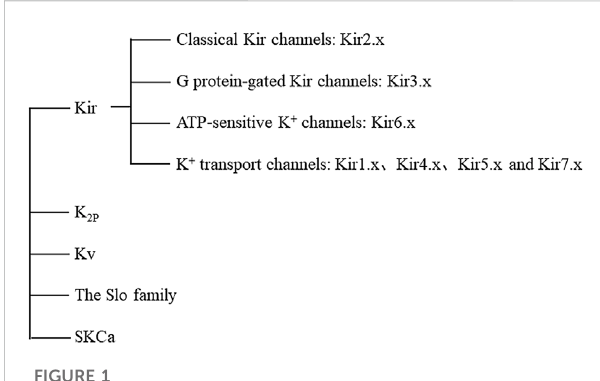
Classi fi cation of potassium channels. Abbreviations: Kir, inward recti fi ers; K 2P , four transmembrane segments with two pores; Kv, voltage-gated; Slo, slowpoke ; SKCa, the Ca 2+ -activated SK family (small conductance calcium activated potassium channels); ATP, adenosine-triphosphate.